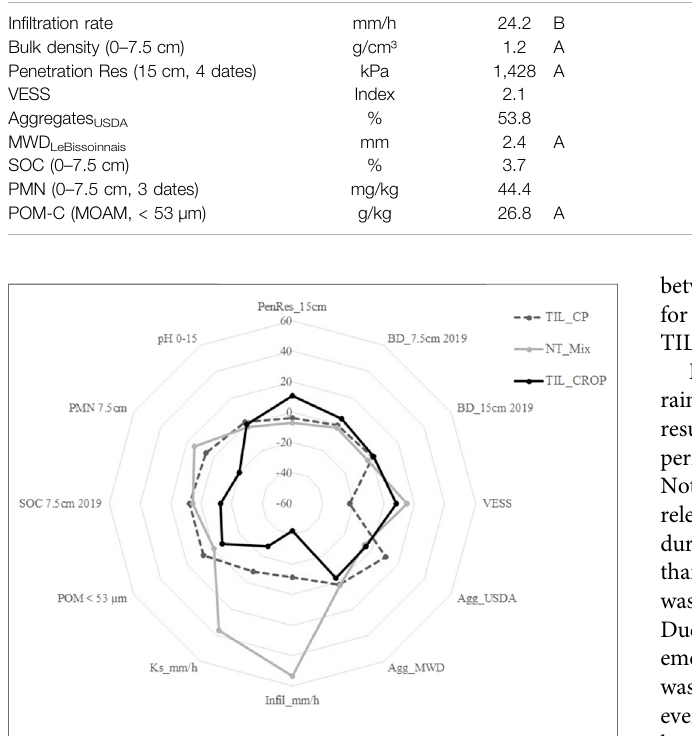
FIGURE 3 | Spider diagram of relative deviations (in %) from the population mean for soil parameters assessed in 2019.